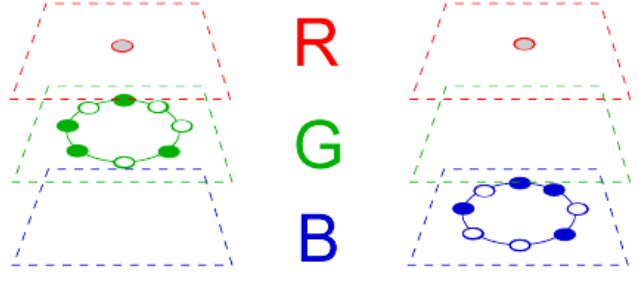
Figure 10. Sampling scheme for the OCLBP RG and OCLBP RB